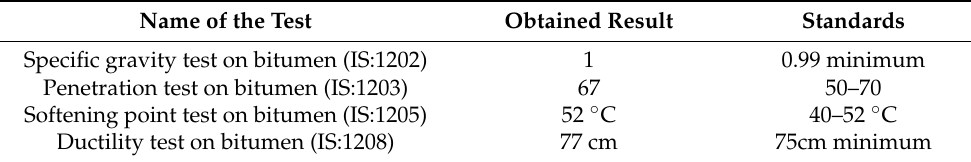
Table 2. Properties of Bitumen.